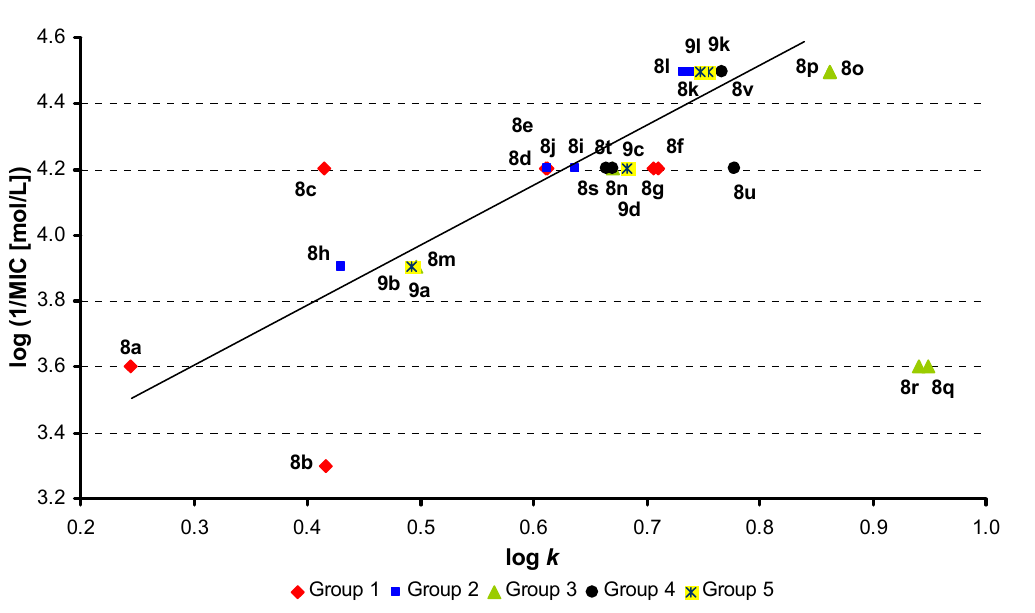
Figure 2. Dependence of antimycobacterial activity against M. kansasii (log 1/MIC [mol/L], 14 h experiment) on compounds lipophilicity expressed as log k